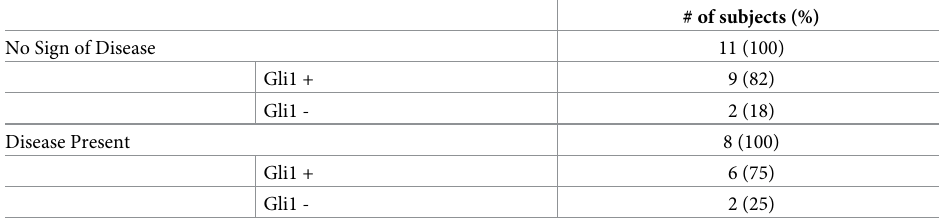
Table 4. Gli1 expression in post-vismodegib excision